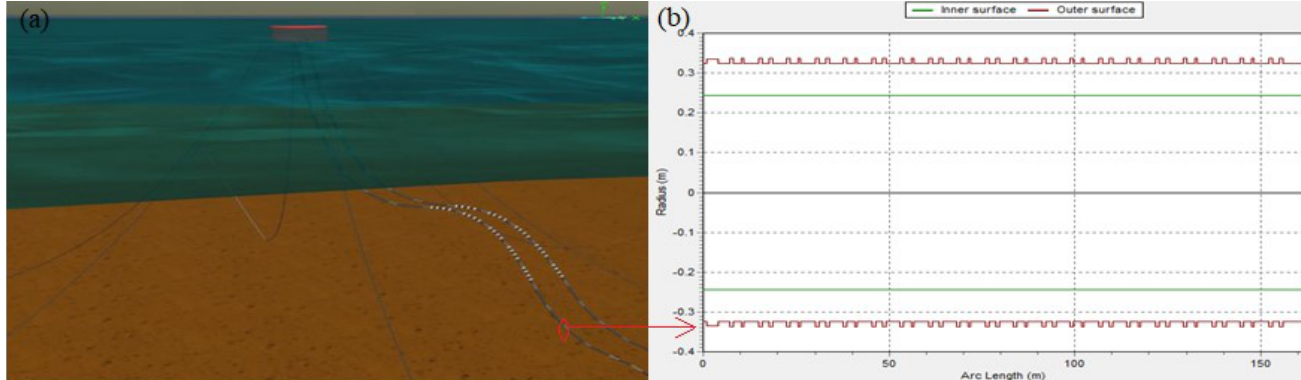
Figure 6. Schematic of marine hoses attached to a floating buoy in Lazy-S config. (Author, but Hose Courtesy: EMSTEC).